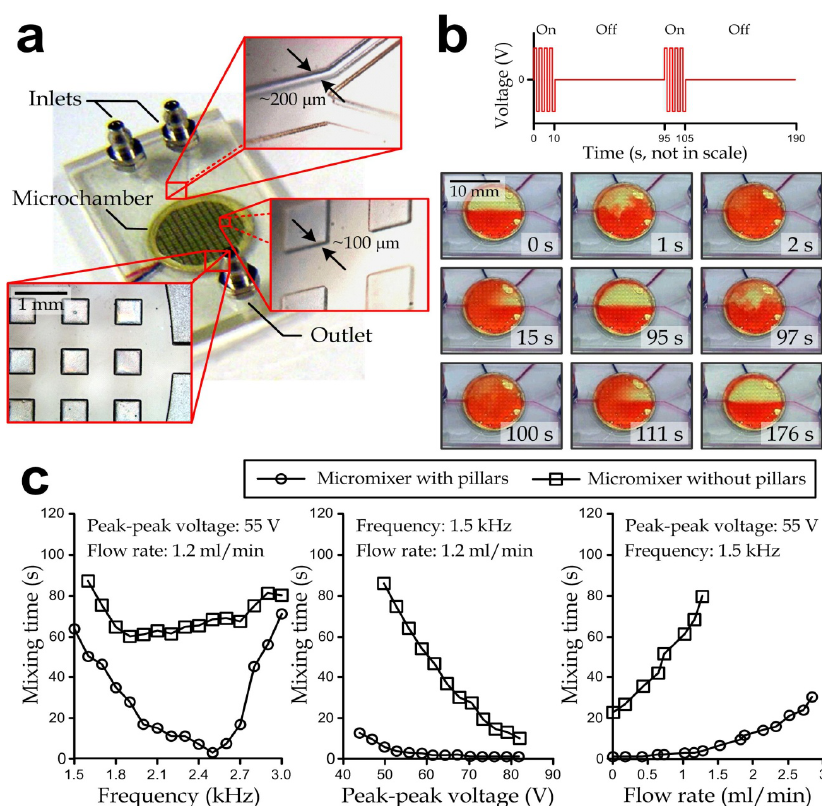
Figure 4. ( a ) Fabricated active micromixer device. Top inset: “Y”-shaped channel region. Right inset: projection view of micro-pillars. Bottom inset: mixing chamber exit; ( b ) Representative time-lapse images of dual-stage micromixing operation. Under